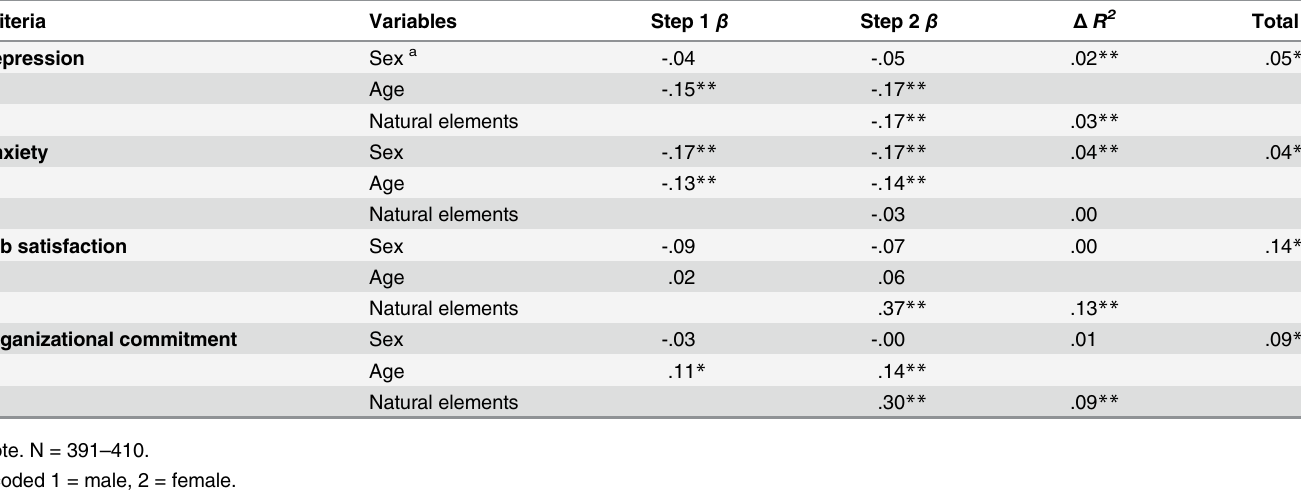
Table 2. Effects of natural elements on outcome variables.